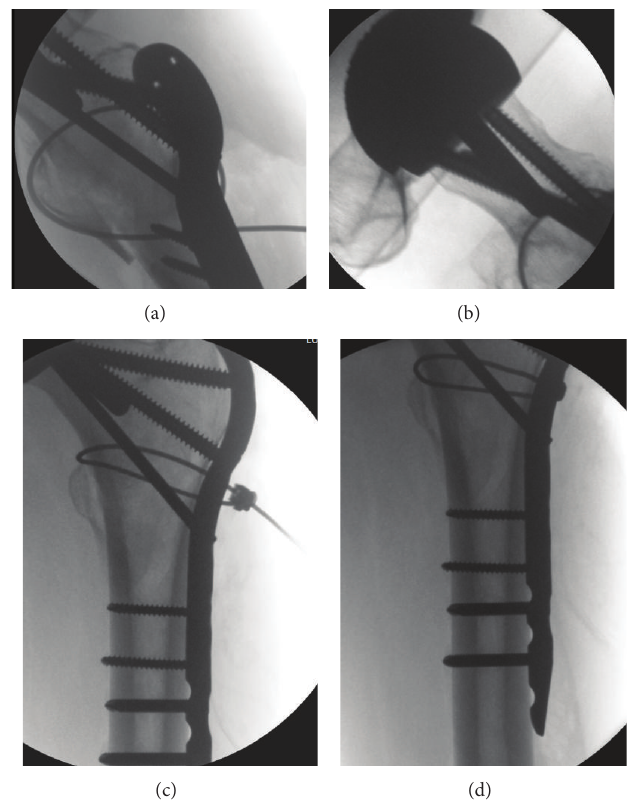
Figure 4: (a)–(d) Showing intraoperative